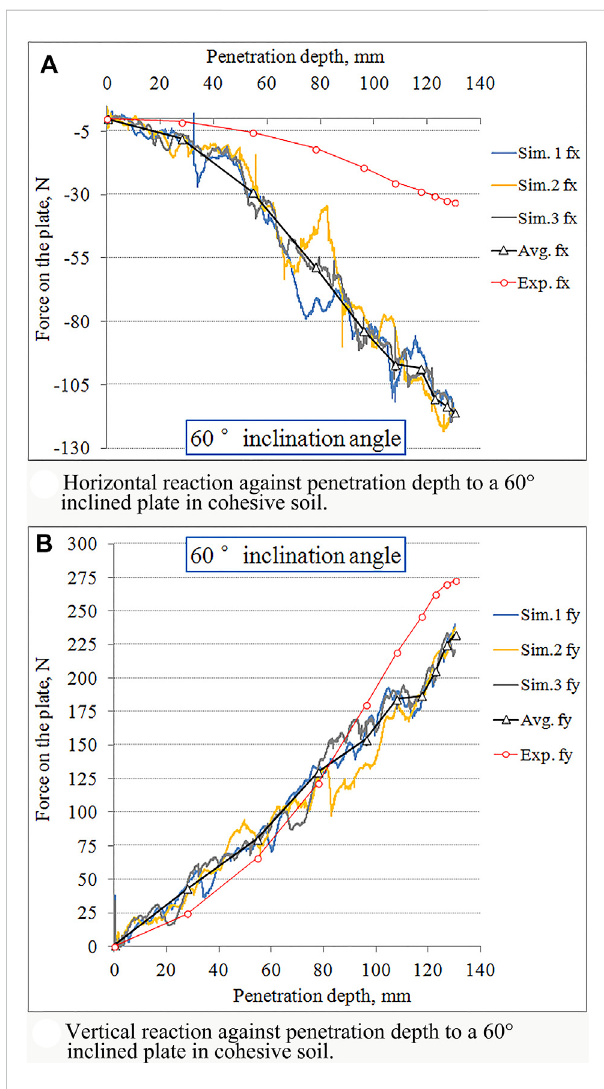
FIGURE 15 Soilreactionvaryingwith penetration depthby60 ° inclinedplate. (A) Horizontal reaction against penetration depth to a 60 ° inclined plateincohesivesoil. (B) Verticalreactionagainstpenetrationdepthto a 60 ° inclined plate in cohesive